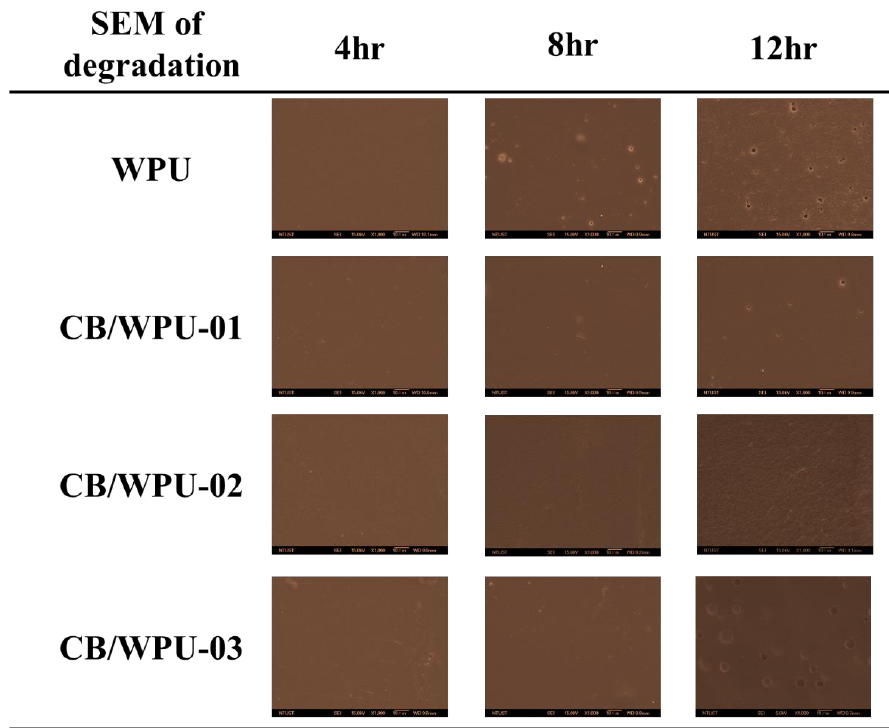
Figure 8. Scanning electron microscope micrographs of the CB/WPUs with hydrolytic degradation for 4, 8, and 12 hours at 45 °C.